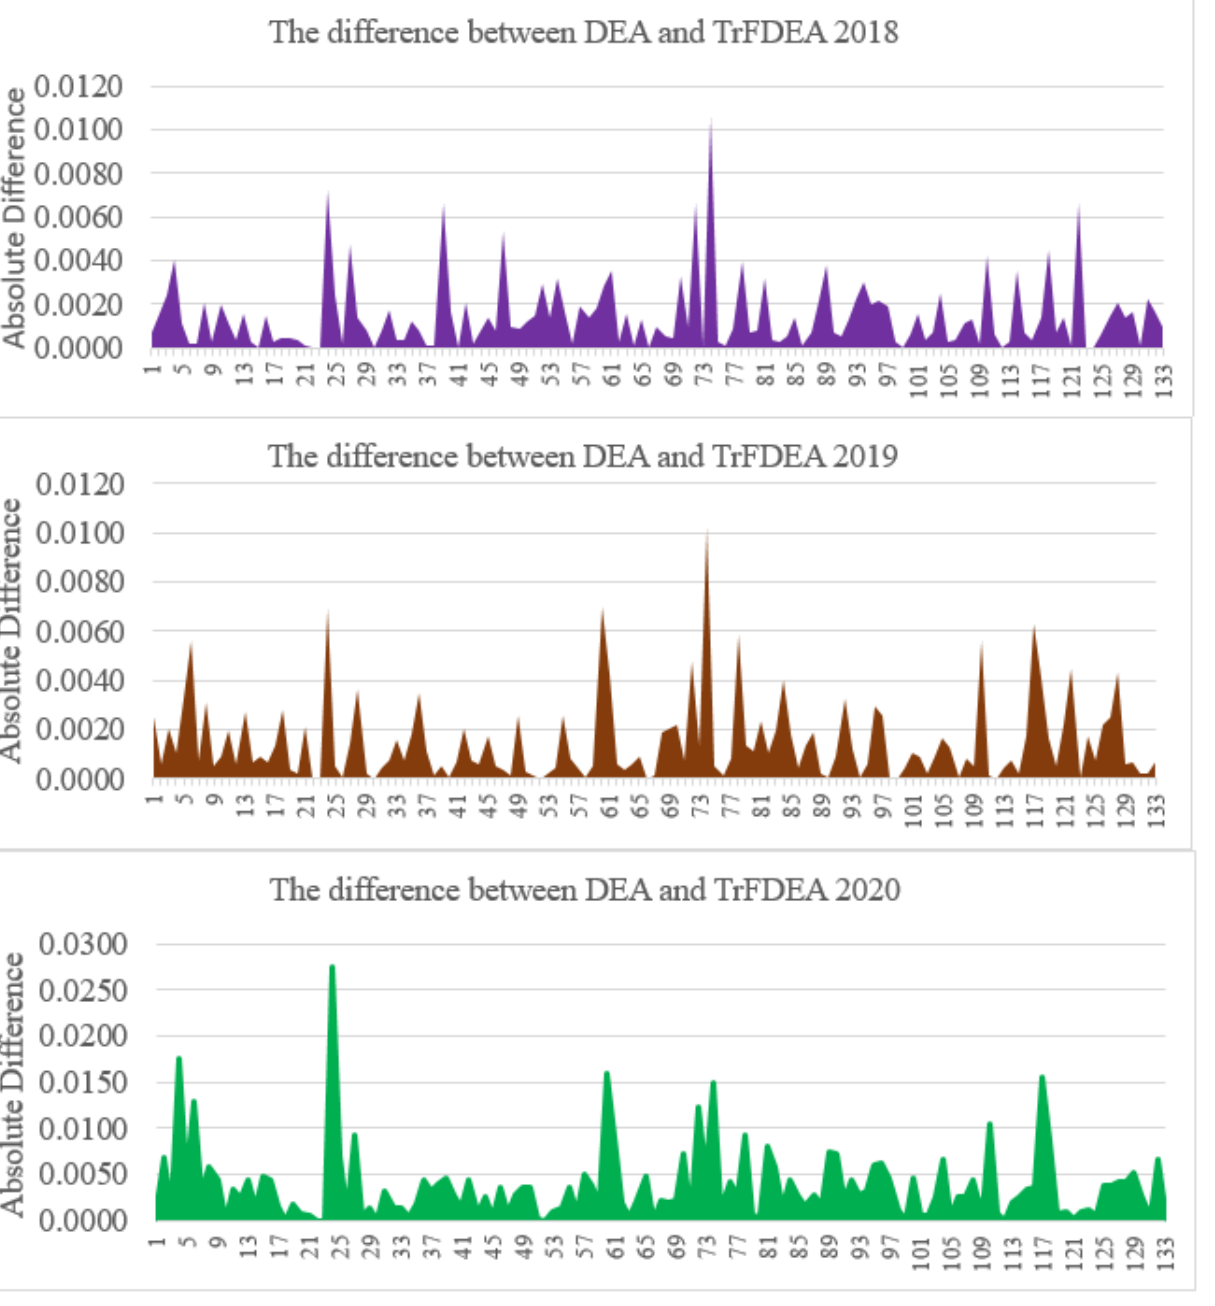
Figure 6. The absolute differences between DEA and triangular fuzzy DEA scores.